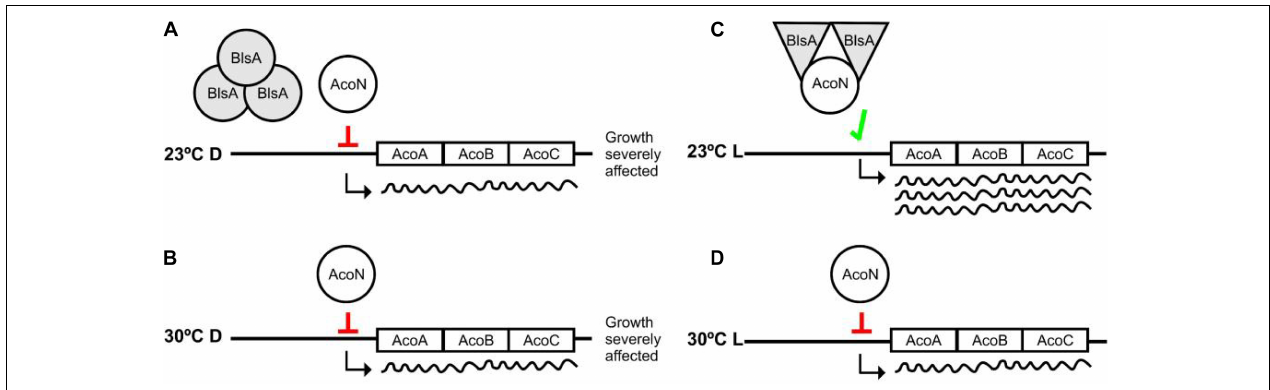
FIGURE 9 | Working model representing photoregulation of acetoin catabolism through AcoN and BlsA. At 23 ◦ C in the dark, BlsA and AcoN do not interact, and AcoN represses expression of the acetoin catabolic genes acoA, acoB, and acoC (A) . As a result, growth on acetoin as sole carbon source is severely affected. Under blue light, BlsA acquires an excited state now capable of interacting with AcoN, antagonizing its functioning, allowing expression from the acetoin catabolic operon, and supporting growth (B) . Overall, BlsA finely tunes AcoN levels in response to light, modulating therefore acetoin catabolism. At 30 ◦ C, both under blue light or in the dark, BlsA does not interact with AcoN maintaining therefore its functioning as a repressor (C,D) , resulting growth severely affected at this